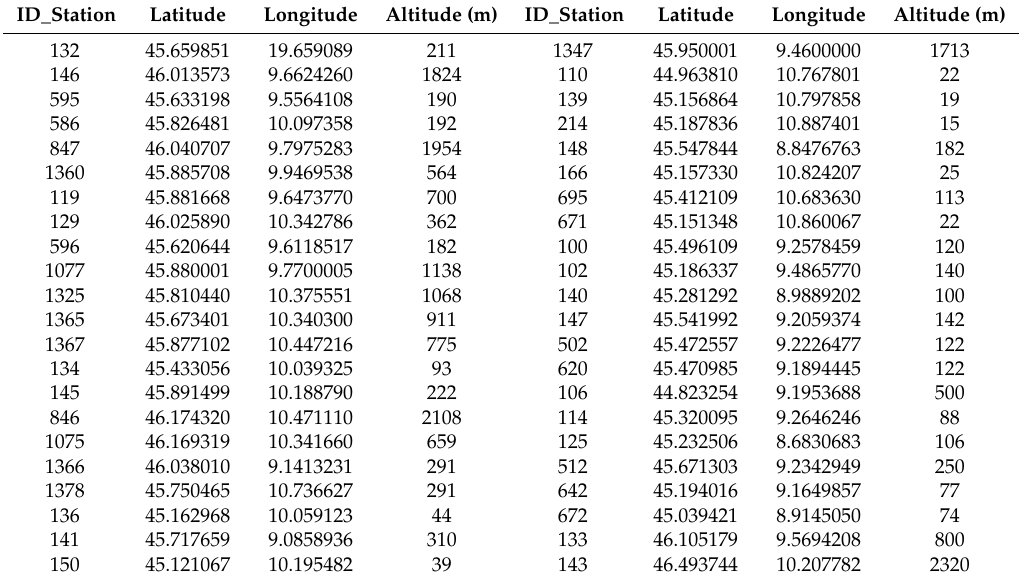
Table 1. Identity code (ID), location, and altitude of ground observation